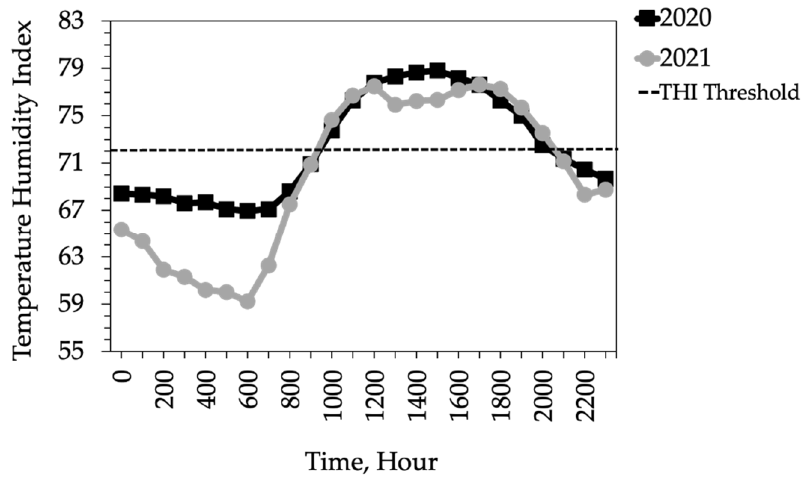
Figure 1. Average temperature-humidity index (THI) by hour during the intravaginal temperature and ewes’ behavior data collection dates for the summers of 2020 and 2021.